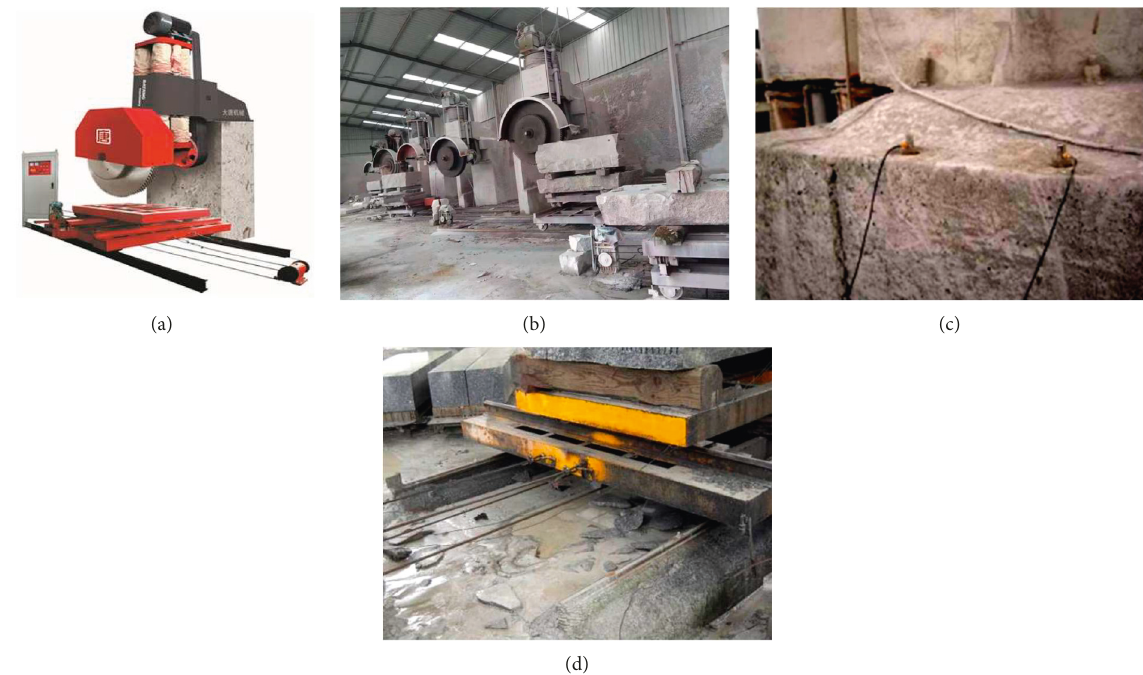
Figure 2: Working diagram of modal test of foundation of stone cutting machine: (a) the 3D model diagram; (b) the field working diagram; (c) the layout diagram of monitoring points; (d) the foundation settlement monitoring.